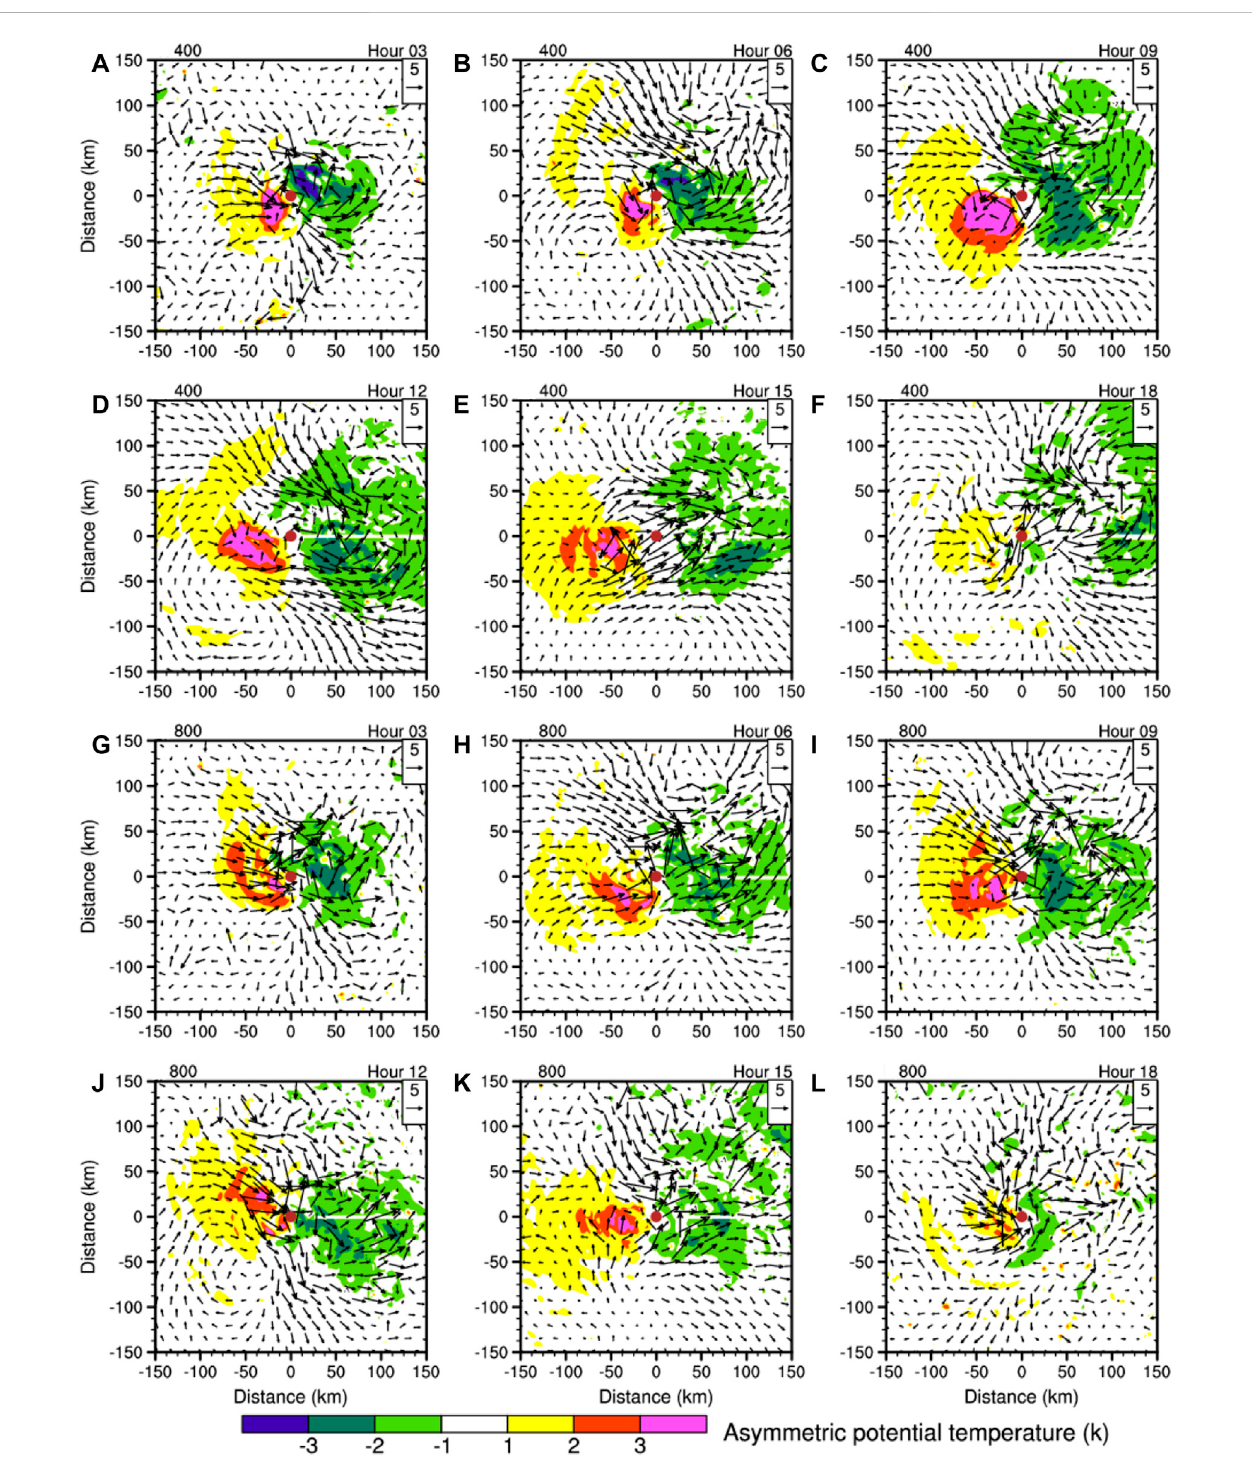
Evolution of diabatic heating (k hour − 1 ) at 3 km, asymmetric potential temperature (blue contours at − 3, − 2, and − 1 K and red contours at 1, 2, and 3 K) at 5 km, and asymmetric winds (vector, m s − 1 ) at 5 km at hour 3, 6, 9, 12, 15, and 18. (A – F) Data from EXP400. (G – L) Data from EXP800. Brown dots indicate the vortex centers at 5